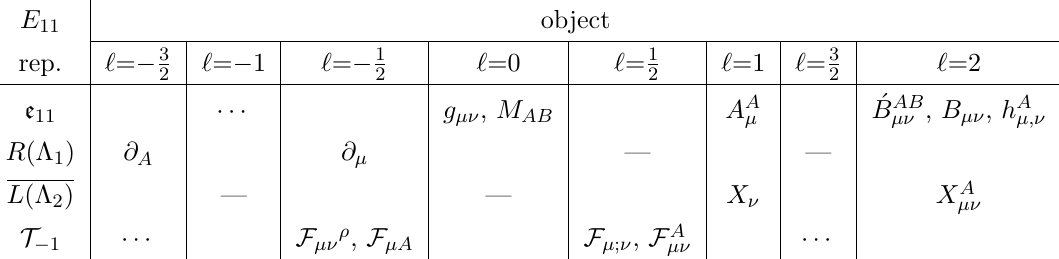
representation at that 8 representations), while ellipses indicate that 11